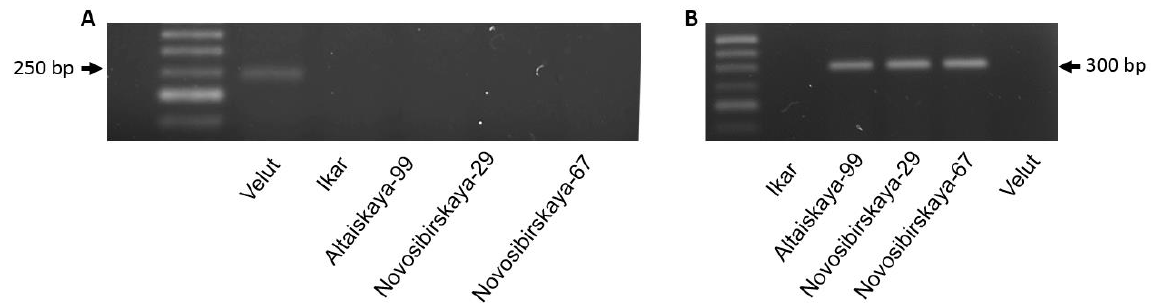
Figure 3. PCR products obtained with the Vrn-B3d-F//R ( A ) and Vrn-B3e-F//R ( B ) markers.